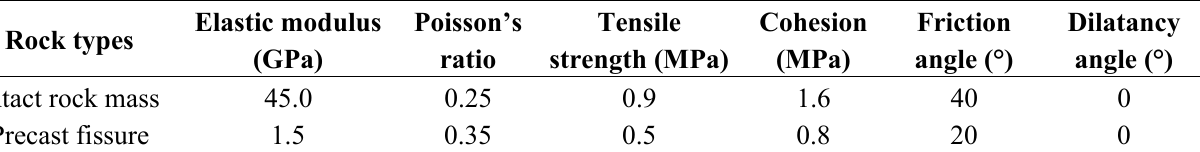
Figure 3. The two-dimensional numerical model. Table 1. Physico-mechanical parameters of intact rock mass and precast